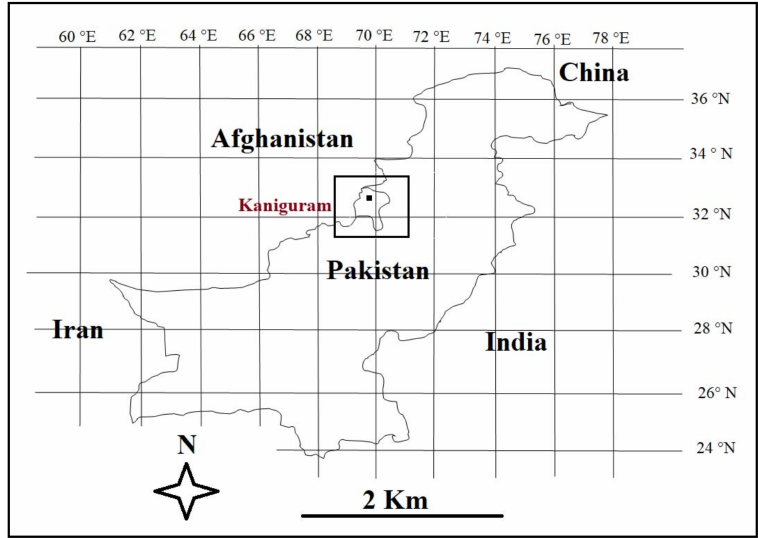
Figure 1. Location of the study area within Pakistan.